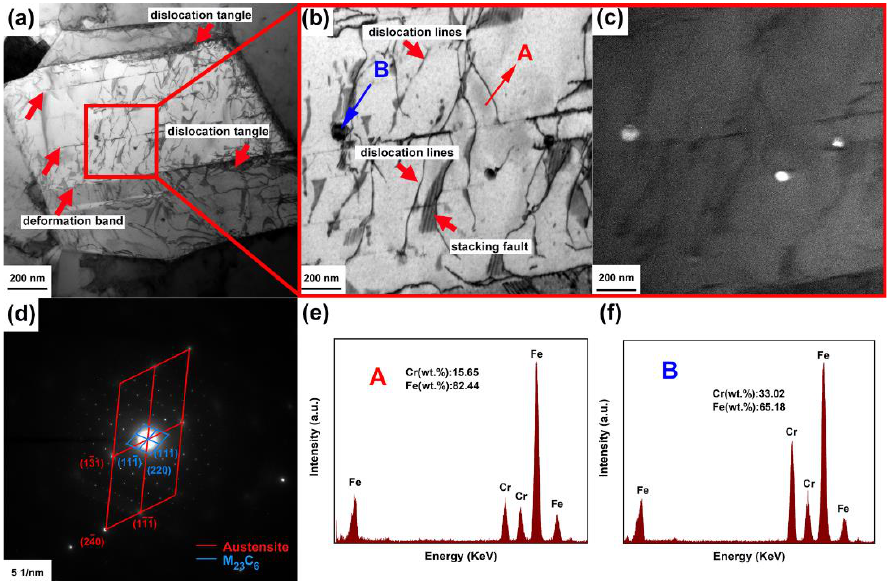
Figure 3. Transmission electron microscopy (TEM) images of the CR-MASS: ( a ) bright-field image; ( b ) the magnified image of the area marked as red frame in ( a ), ( c ) corresponding dark-field image of ( b ), and ( d ) the selected-area electron diffraction pattern (SADP) of M 23 C 6 carbides and austenite. ( e , f ) separately indicate the chemical composition of steel substrate (point A in ( b )) and the M 23 C 6 carbides (point B in ( b )).